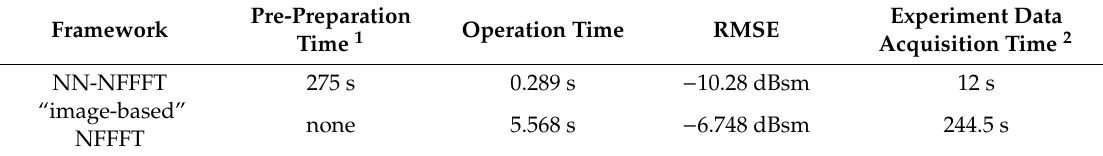
Table 1. Temporal comparison.